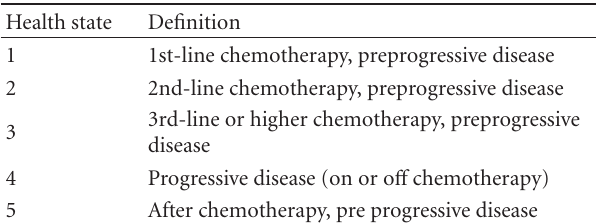
Table 1: Predefined health